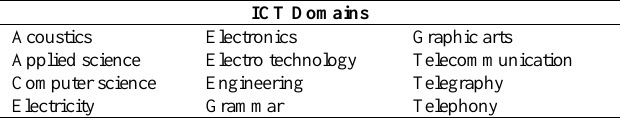
Table 2. ICT domains in Domain WordNet.